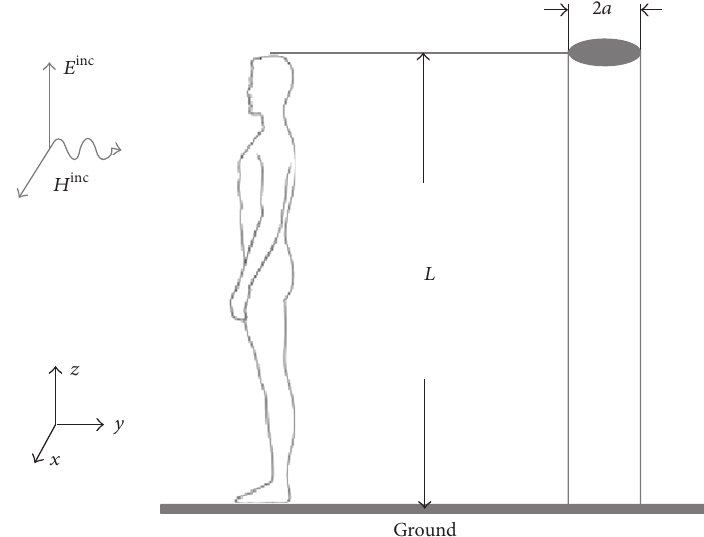
Ground Figure 1: Cylindrical model of the human body exposed to electromagnetic